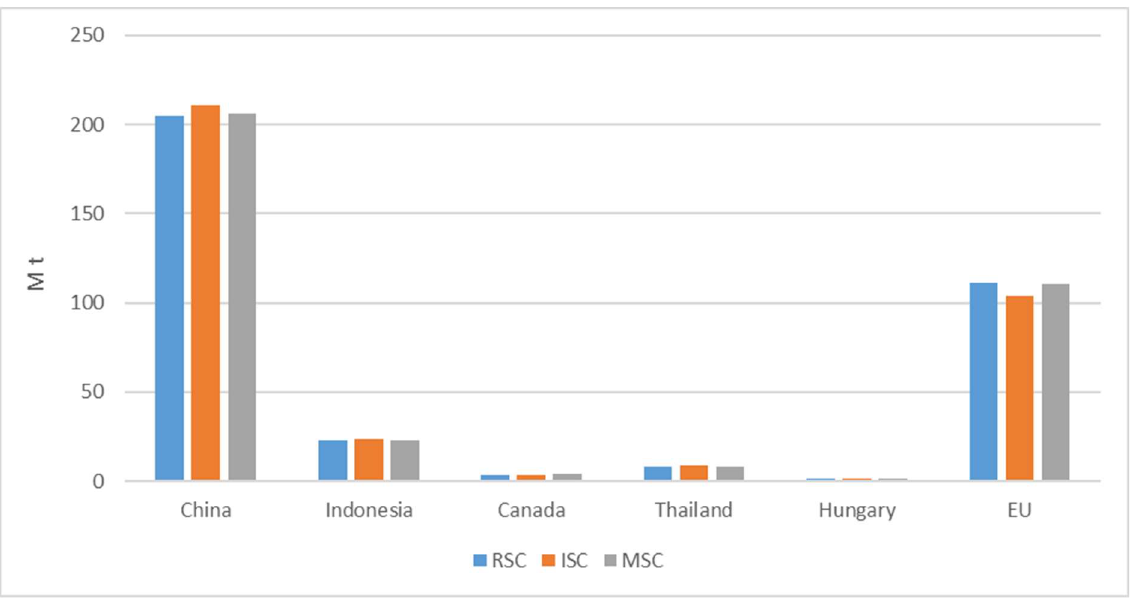
Figure 9. Production of paper and paperboard in the countries with the greatest changes (ranking of countries is according to changes in ISC vs. RSC) and the EU: RSC (blue), ISC (orange) and MSC (grey) in 2050 [authors’ results].